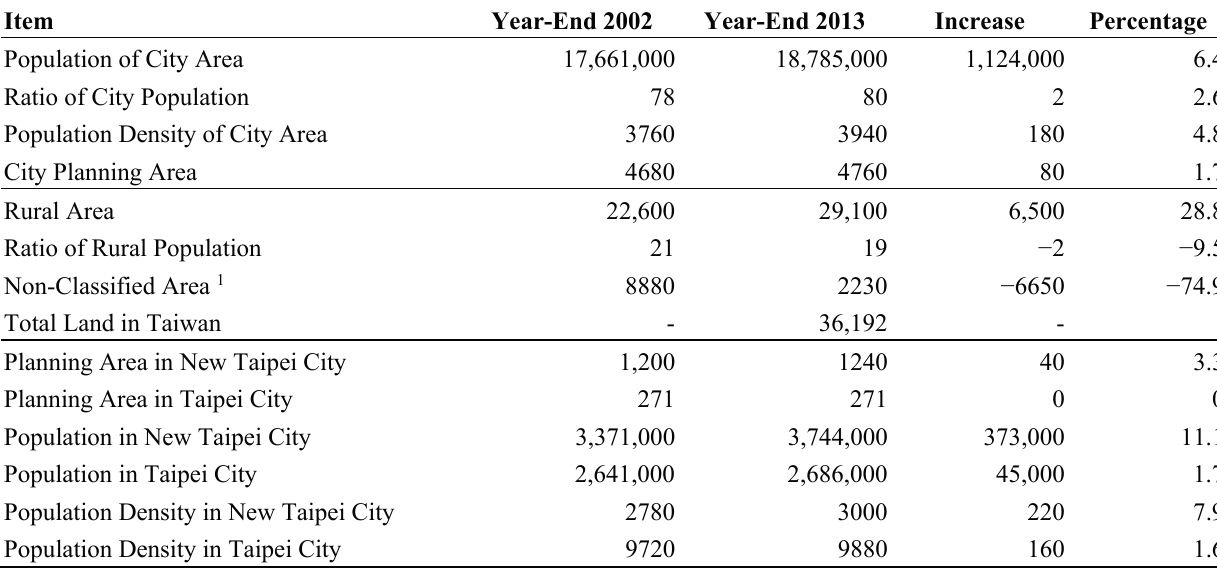
Table 1. City development of Taiwan, 2002 to